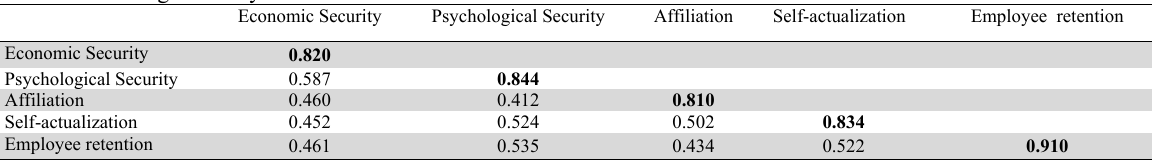
Correlation among the study